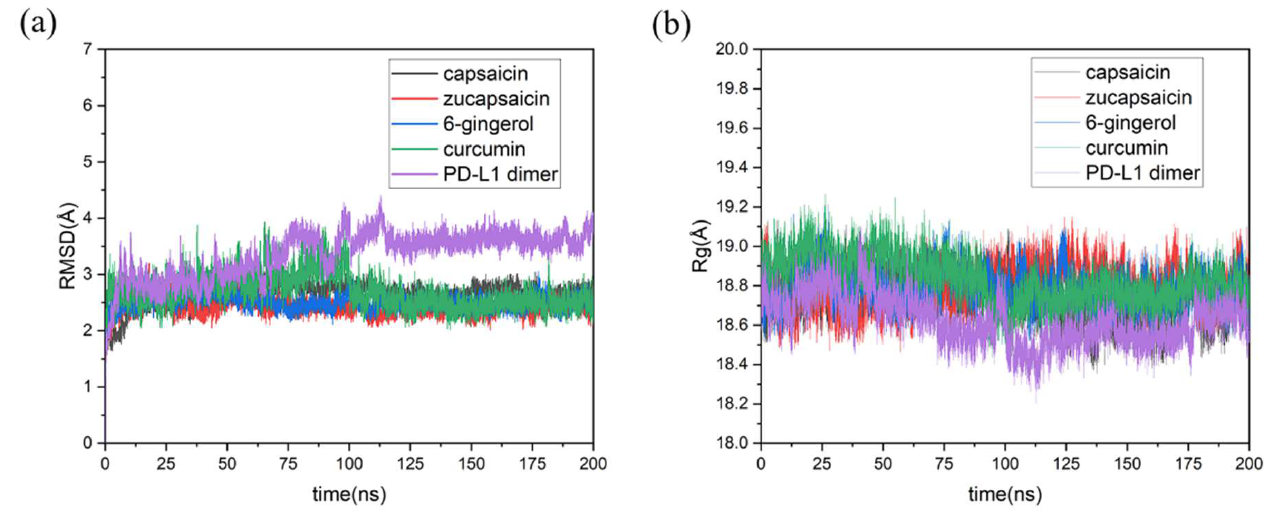
Figure 3. Estimation of MD simulation equilibration and analysis of the stability of dimer structure. Time evolutions of ( a ) the residues RMSD within 20 Å of binding site and ( b ) the radius of gyration ( R g ) in protein.